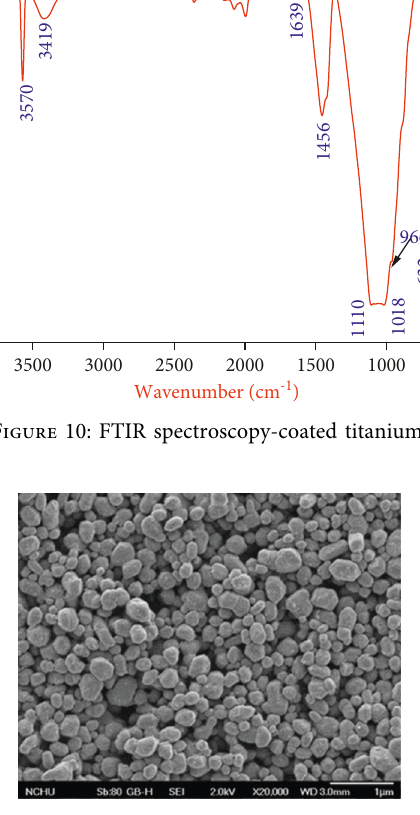
Figure 11: SEM micrographs of HAp coated